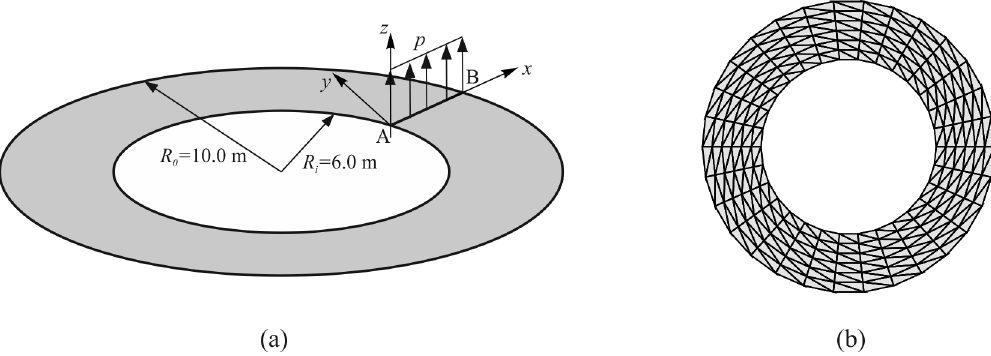
Figure 15. Slit annular plate: ( a ) geometry with loading condition; and ( b ) discretisation.